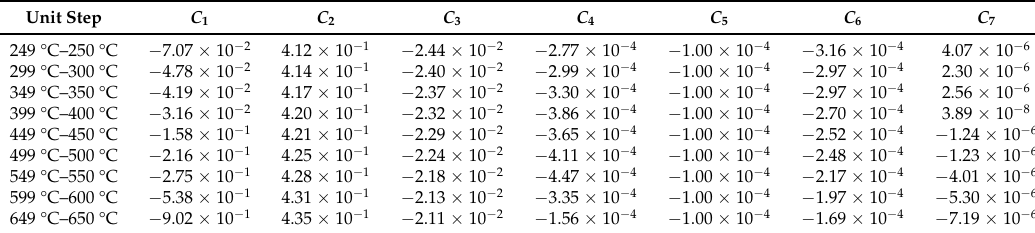
Table 4. A summary of Green’s function coefficients fitted to the unit thermal stress responses.